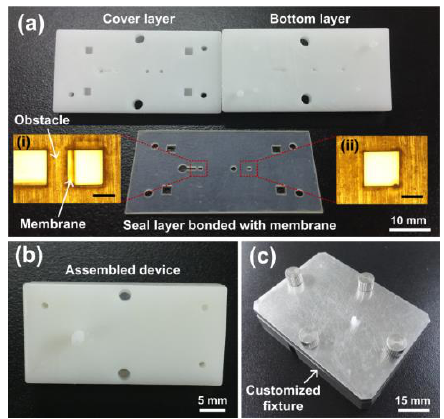
Figure 7. Prototype of the microfluidic flow regulatory device. ( a ) Cover layer, bottom layer, and seal layer with a bonded membrane. Inset images (i) and (ii) illustrating the enlarged membrane structures of the flow check valve and the flow regulating valve. Scale bar 500 μm; ( b ) Assembled prototype; ( c ) Customized fixture holding the prototype. Micromachines 2019 , 10 , 653